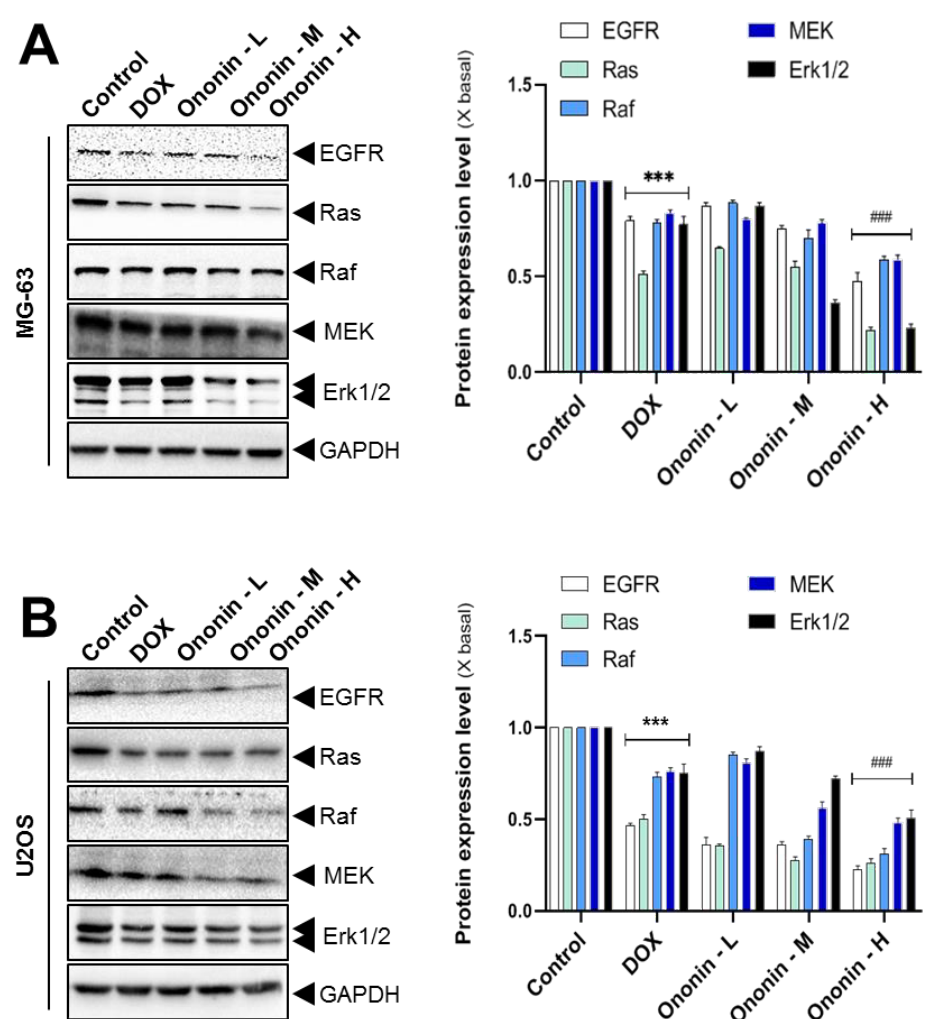
Figure 4. ( A ) Cultured MG-63 or ( B ) U2OS cells were incubated with DOX (1 µ M) or ononin (0.1, 0.3, and 1 µ M, labeled as -L, M, and –H) for 2 days, and the target proteins were detected by Western blot (left panel). The quantification of the target protein was calculated with a densitometer (right panel). The values are expressed as the fold of change (X basal), in Mean ± SEM, where n = 3. *** p < 0.01 was considered a significant result when compared to control, and ### p < 0.001 was considered a significant result when compared to DOX group. Full Western blot images can be found at Supplementary Materials